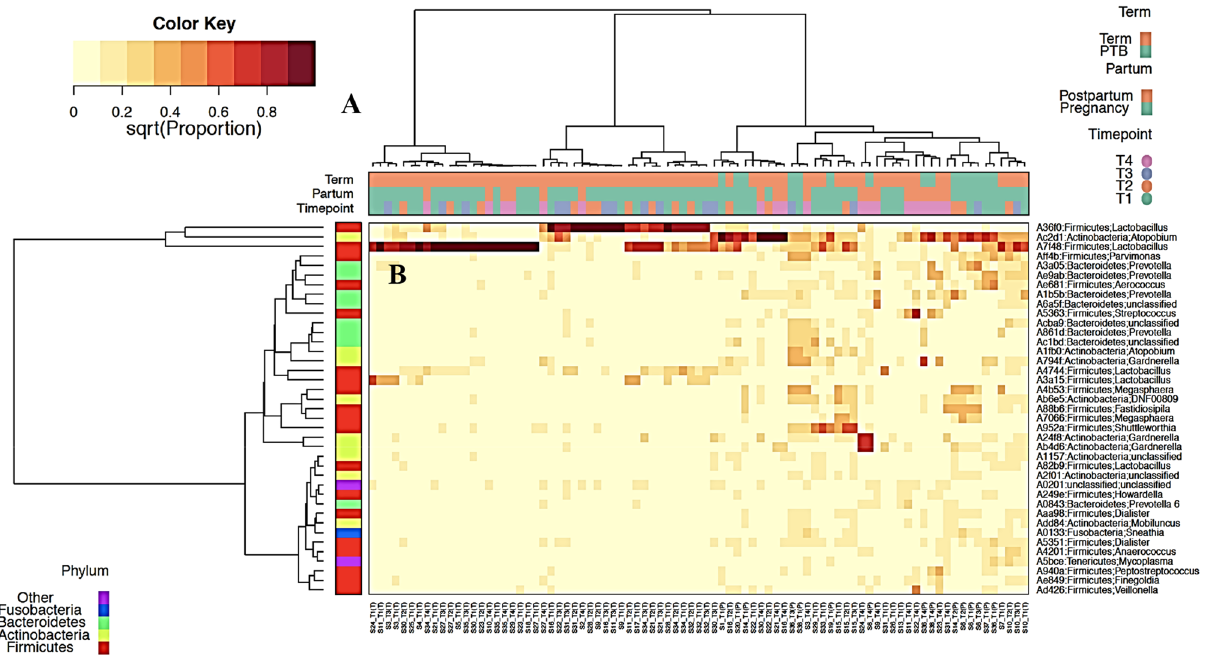
Figure 1. Bacterial species composition of vaginal community state types (CST) during pregnancy and postpartum. (A) Hierarchical clustering based on amplicon sequence variant (ASV) abundance, Hellinger distance (Euclidean distance on square-root proportion data), Wald. D linkage reveals microbiome from a Nigerian cohort can be clustered into 4 community clusters. (B) Heatmap of relative abundance of amplicon sequence variants characterizing the community state types represented. Figure created with R using the R ‘GMD’ package version 0.33. https:// www. rdocu menta tion. org/ packa ges/ GMD/ versi ons/0. 3.3.